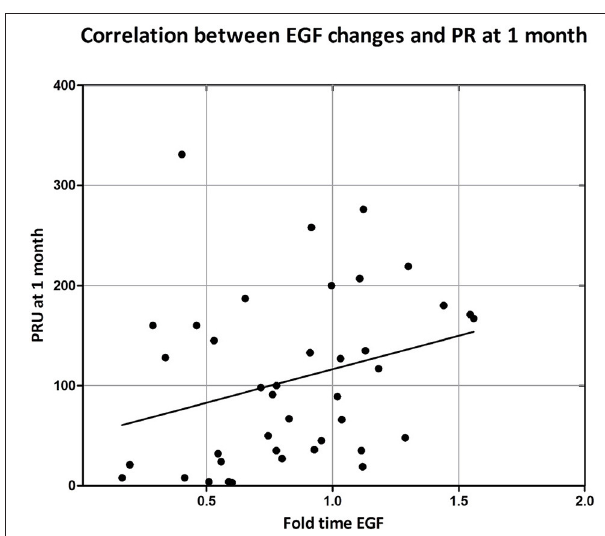
FIGURE 2 | Correlation between on-treatment platelet reactivity at 1 month and EGF changes. On treatment platelet reactivity was measured by VerifyNow after and expressed as P2Y 12 reaction unit (PRU). EGF changes were expressed as ratio between serum EGF concentration at 1 month over serum EGF concentration at baseline. Correlation was assessed by Spearman correlation test: R = 0.350; p = 0.020.